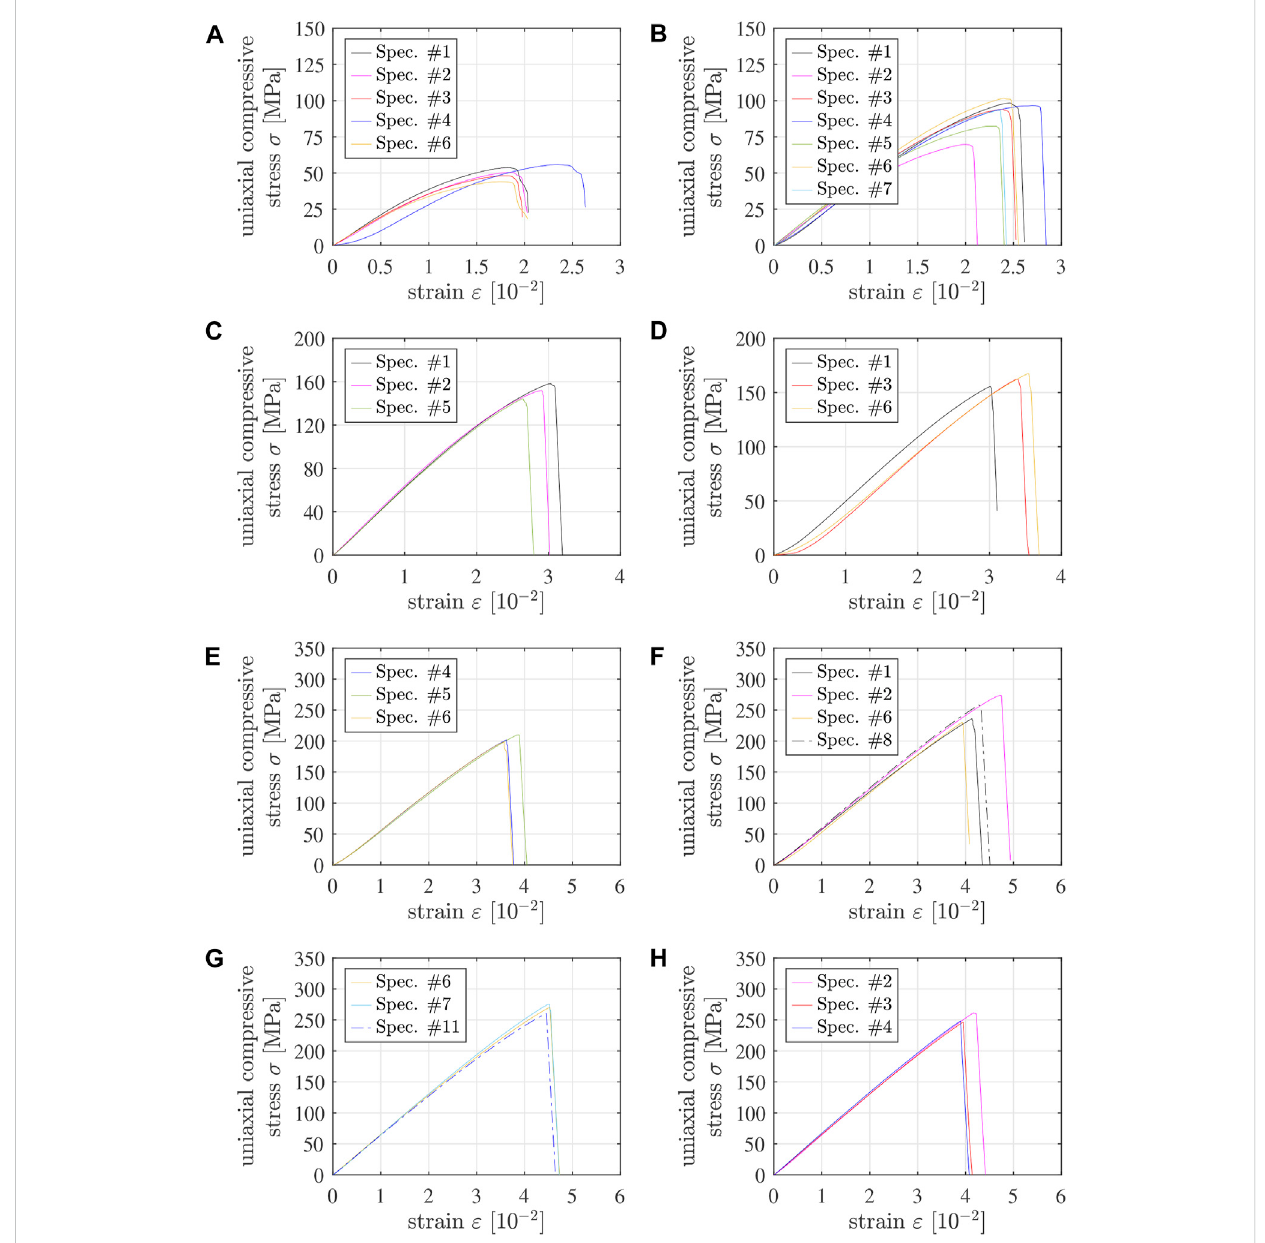
FIGURE 4 Stress-strain diagrams from destructive compression experiments of 5/10 specimens tested (A) 1 h, (B) 1.5 h, (C) 3 h, (D) 7.5 h, (E) 25.5 h, (F) 7 days, (G) 14 days, and (H) 21 days after production; the solid graphs refer to specimens #1 throughout #7, with the following color code: #1 - black, #2 - pink, #3 - red, #4 - dark blue, #5 - green, #6 - yellow, #7 - light blue, see also Table 4 and Supplementary Table S1; the dash-dotted lines refer to specimens with numbers greater than 7. Note that “ strain ” refers to the sum of the absolute values of the compressive axial strain undergone by the specimen and the tensile axial strain undergone by the testing